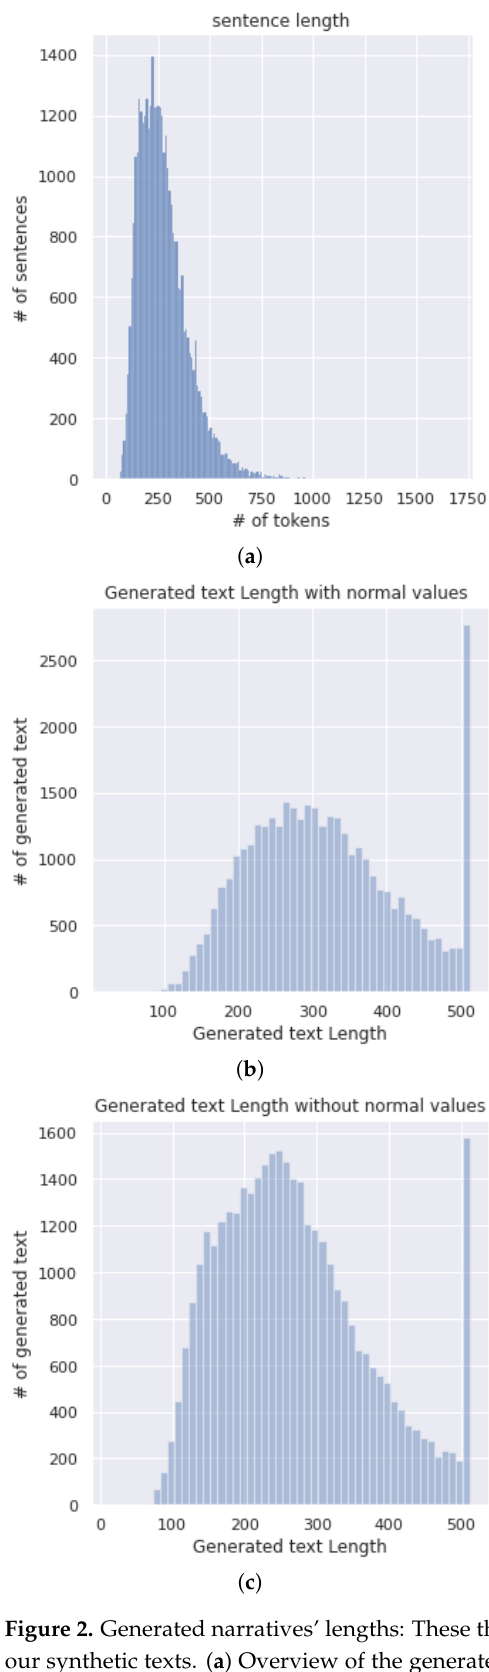
Figure 2. Generated narratives’ lengths: These three graphs provide an overview of the lengths of our synthetic texts. ( a ) Overview of the generated text; ( b ) sentences of ≤ 512 tokens with normal values; ( c ) sentences of ≤ 512 tokens without normal